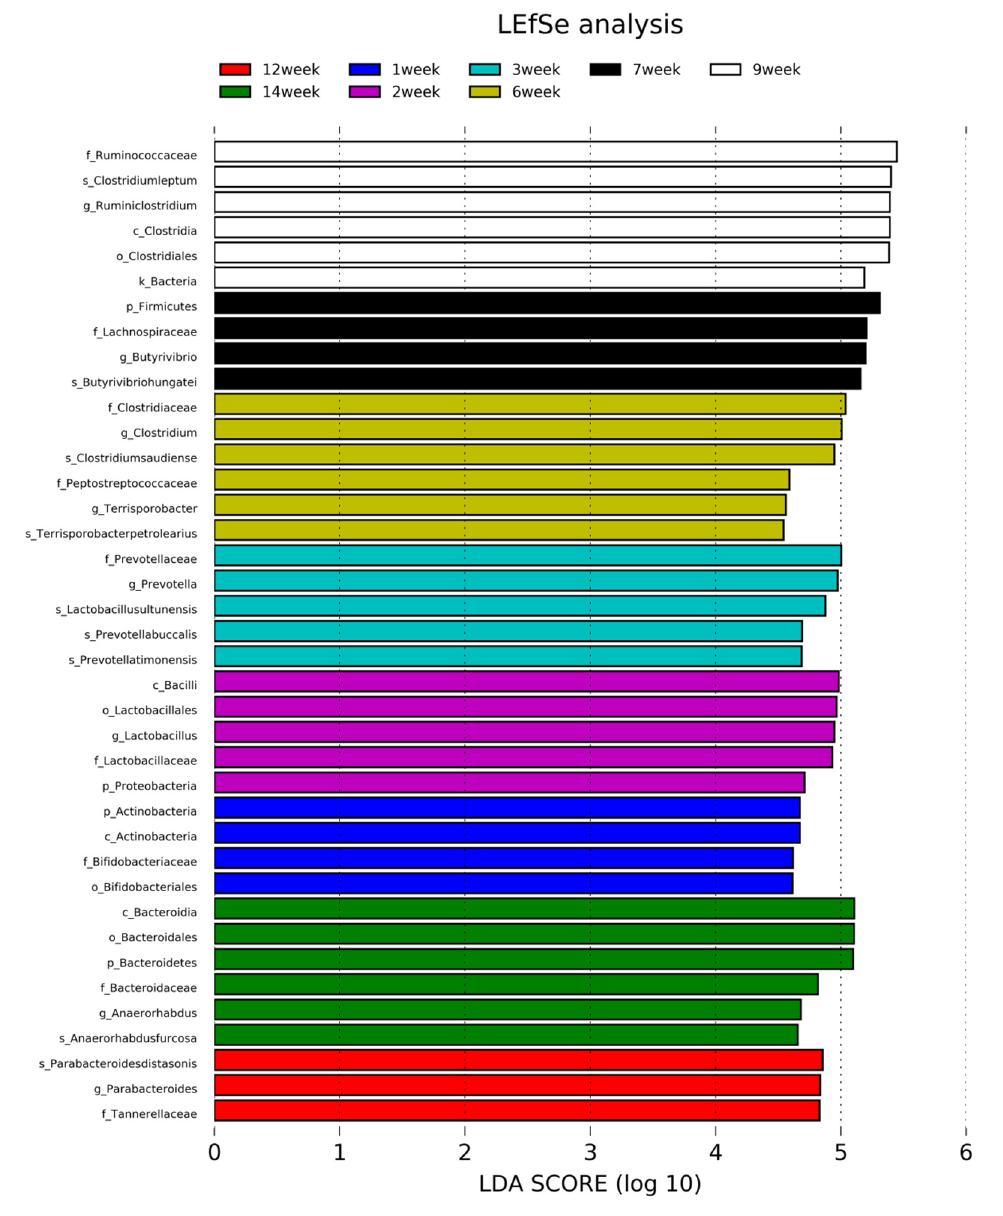
Figure 6. Marker microbiome identification through the linear discriminant analysis (LDA) effect size method (LEfSe), Color code is indicated according to week.